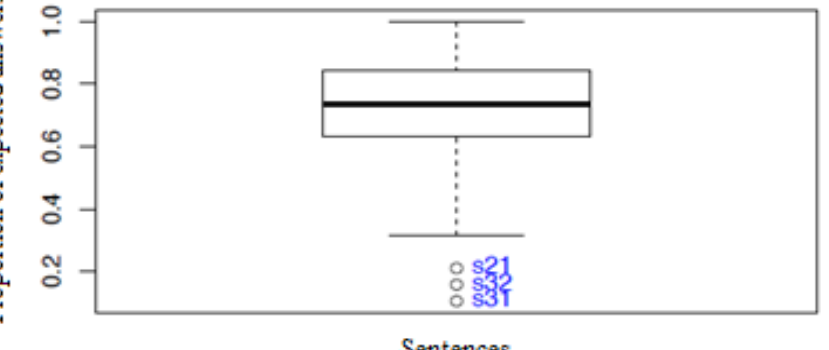
Figure 1 . Boxplot for all the sentences